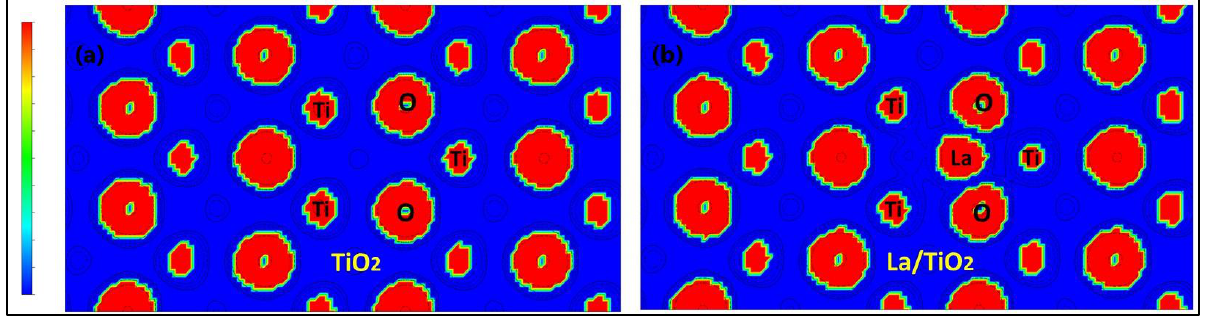
Figure 6. Representation of ELF with contour lines of ( a ) TiO 2 and ( b ) La/TiO 2 surfaces, where red means strong electron localization and blue means the opposite.